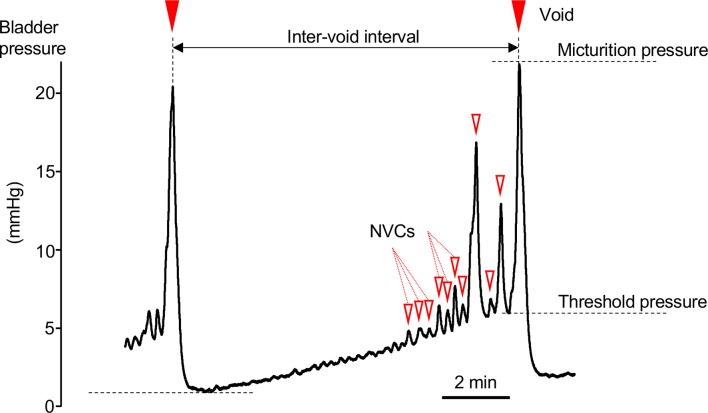
Cystometrogram.Typical cystometrogram trace showing two complete voids and the intervening storage phase in response to a continuous infusion of saline to the bladder. The measured variables are indicated on the bladder pressure trace:• Inter-void interval as time between successive voids.• Basal pressure was taken as the lowest bladder pressure reached after a void.• Voiding threshold was the bladder pressure at the point of initiation of voiding.• Micturition pressure was the peak bladder pressure achieved during a void.• Non-voiding contractions (NVCs, open triangles marking some of the events) were identified as discrete increases in bladder pressure (>0.1 mmHg) observed during the filling phase.